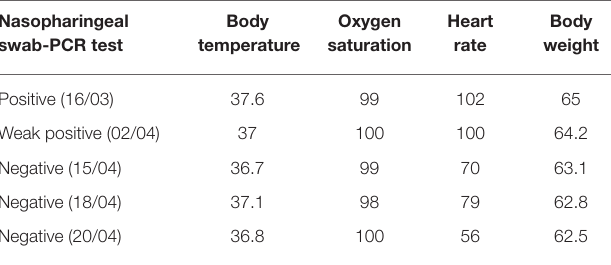
TABLE 1 | Trend of the main health parameters (body temperature, oxygen saturation, heart rate, body weight). Nasopharingeal swab-PCR